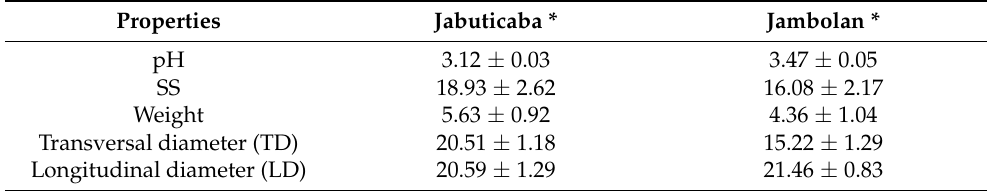
Table 1. Physicochemical characteristics of jabuticaba and jambolan fruits: soluble solids (SS) ( ◦ Brix), average weight (g), transversal (mm) and longitudinal (mm)